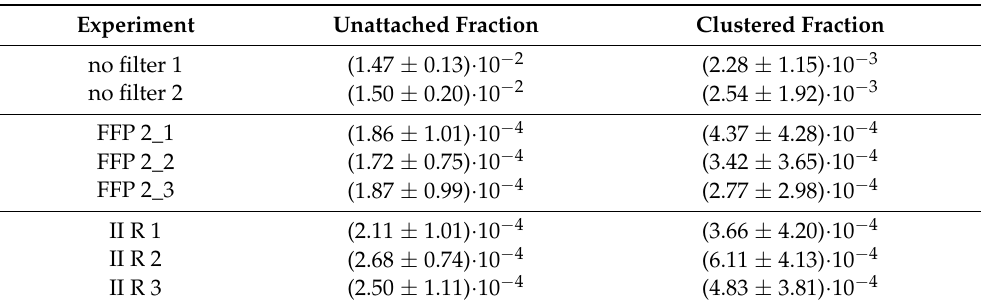
Figure 5. EEC of unattached and clustered fractions in relation to the radon activity concentration at the same time for measurements without filter and for the individual experiments with FFP2 mask. The box describes the values from the first to the third quartile, the whisker the 1.5 interquartile range, the horizontal line depicts the median, the cube the mean and diamonds outliers (no filter: N = 2, n = 65; FFP2: N = 3, n = 122; II R: N = 3; n = 122). Significance was tested with Welch’s test. p -values are indicated by asterisks, with * for p ≤ 0.05, ** for p ≤ 0.01 and *** for p ≤ 0.001. Table 2. Summary of individual experiments without a filter and with FFP2 and II R masks. Values represent the EEC normalized to the radon activity concentration for the unattached and the clustered fractions.